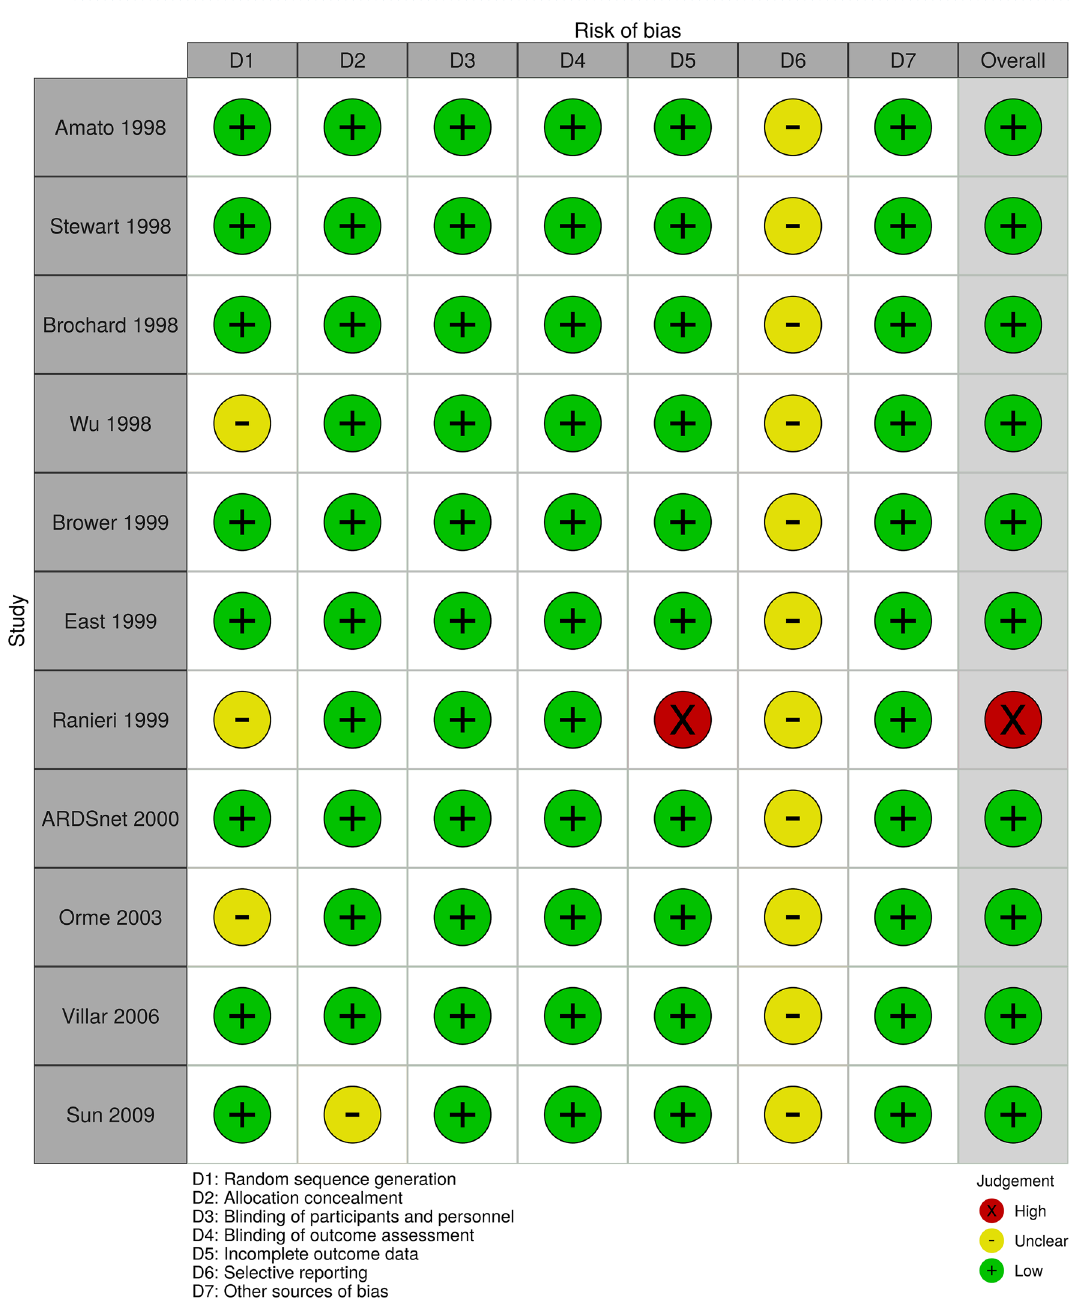
Figure 2. Traffic light plot of the risk of